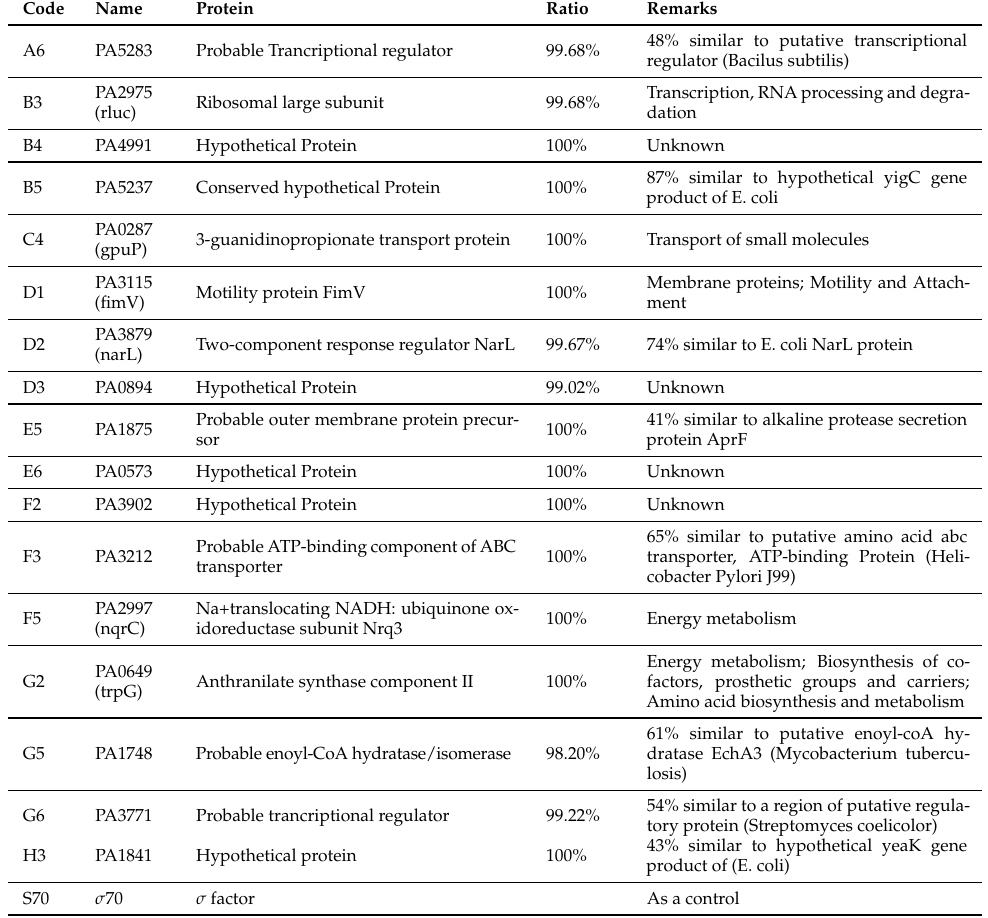
Table 4. 18 genes in P. aeruginosa